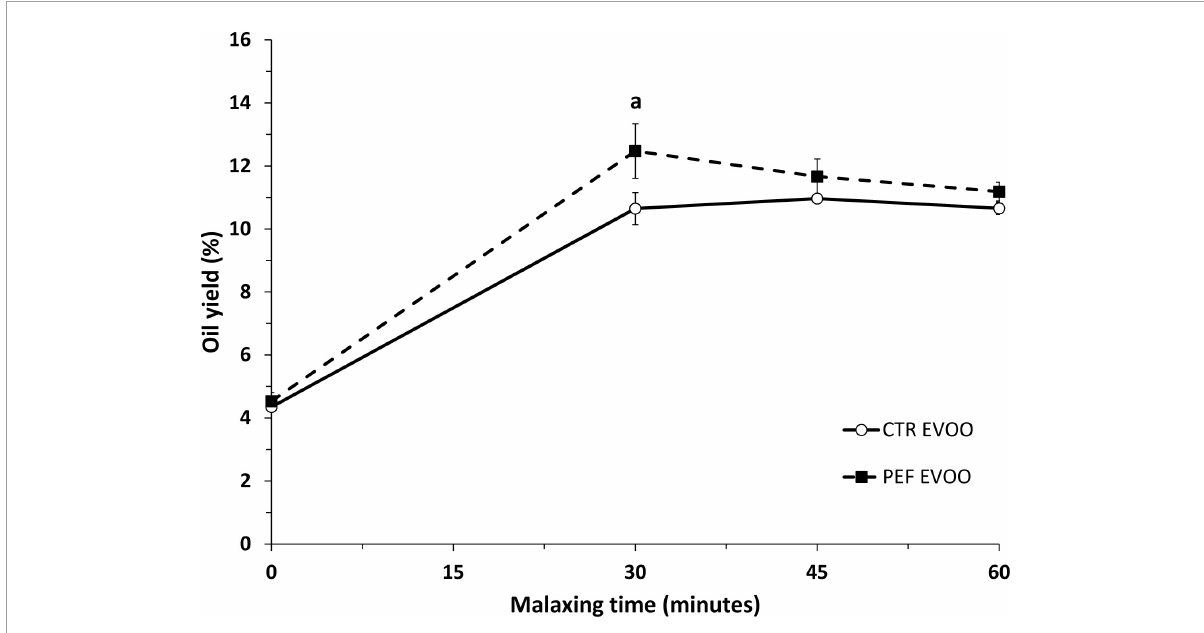
FIGURE1 Extravirgin olive oil (EVOO) yields according to different procedures. Data were obtained using Abencor method of the EVOO at 21 ± 1 ◦ C at different malaxing times. Data are means ± SD for each point of triplicate determinations. Statistical analysis was carried out by Student’s t -test. a p <